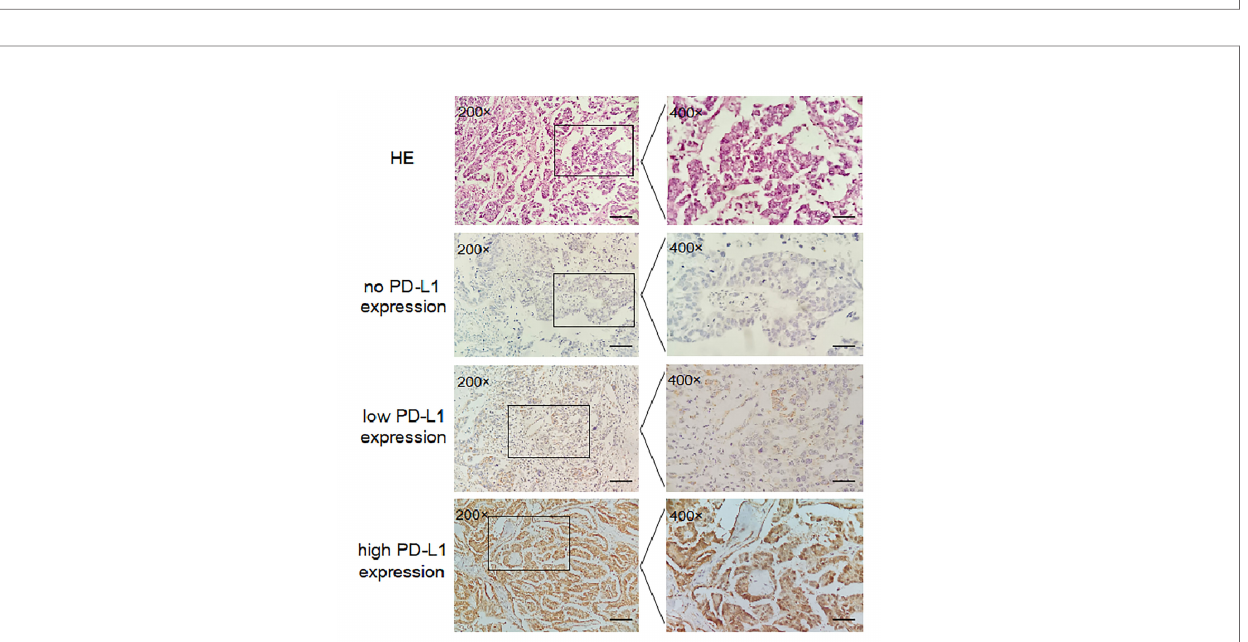
FIGURE 4 | Expression of PD-L1 in EOC tissues detected by IHC (200× and 400×). HE; no PD-L1 expression; low PD-L1 expression; high PD-L1